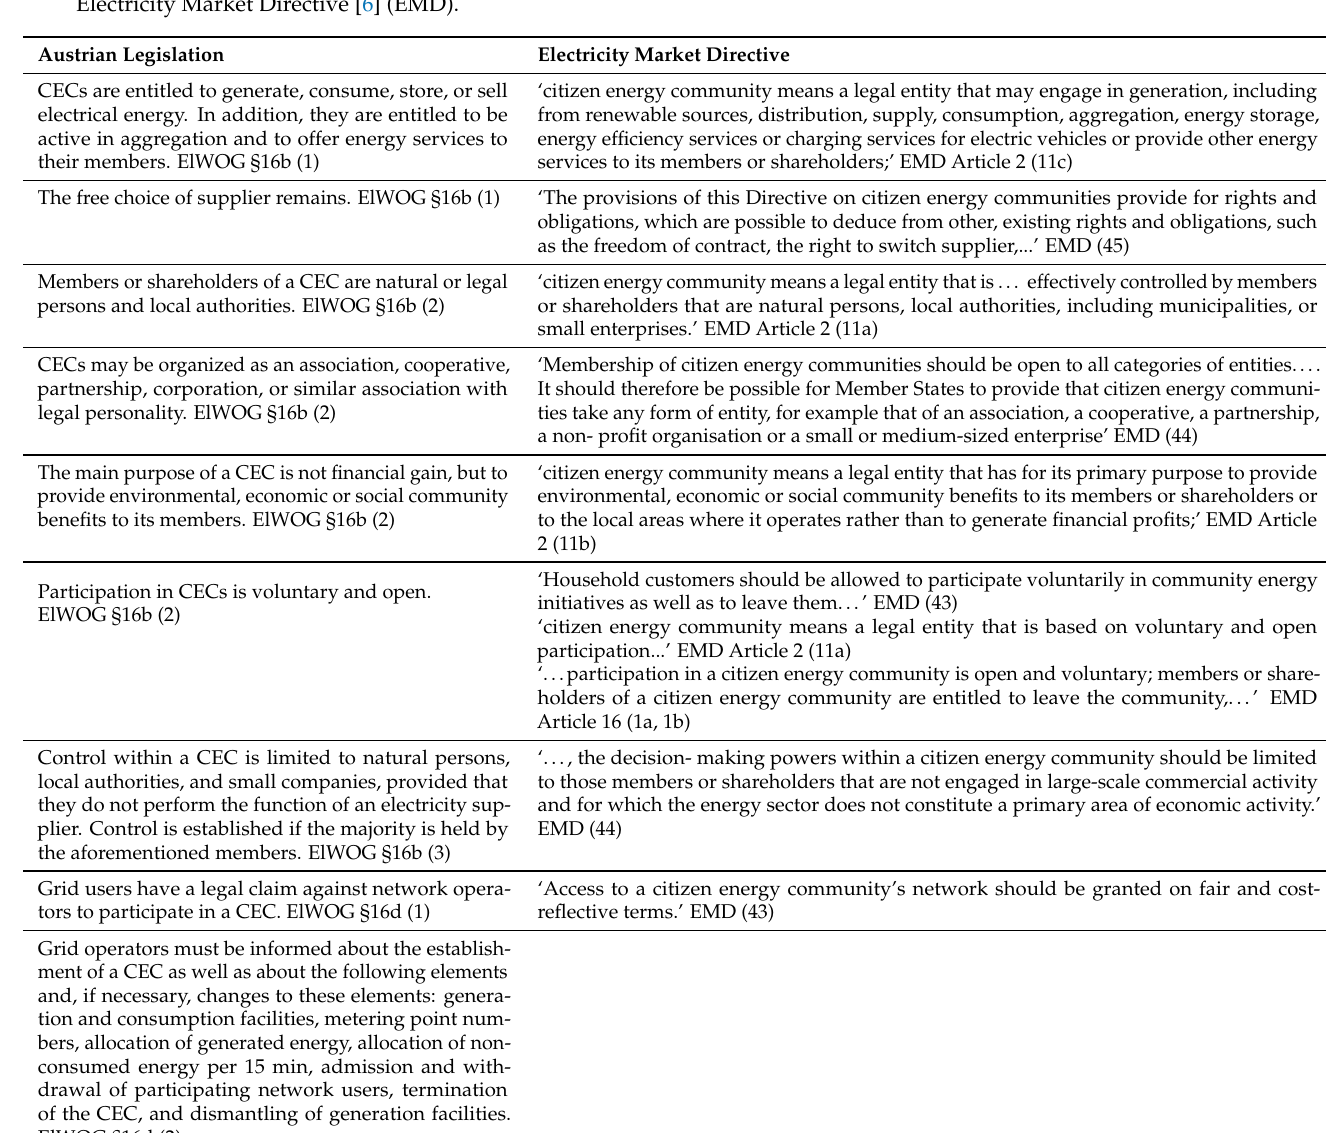
Table 2. Austrian legislation on Citizen Energy Communities (CECs) compared with the European guidelines of the Electricity Market Directive [6]